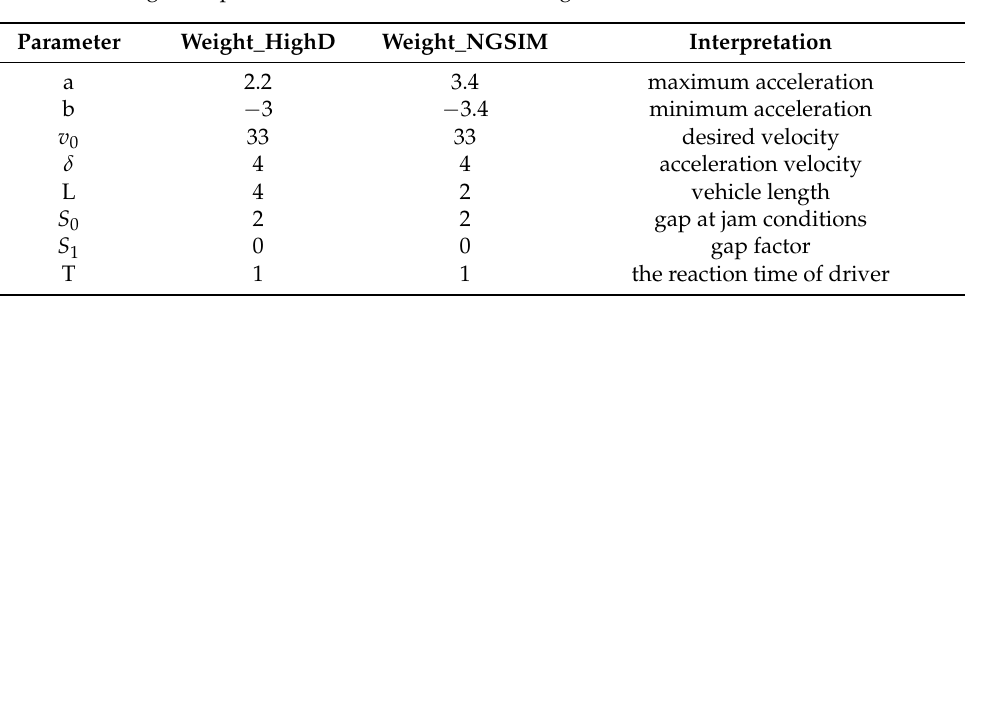
Table 3. The weights of parameters in IDM in car-following